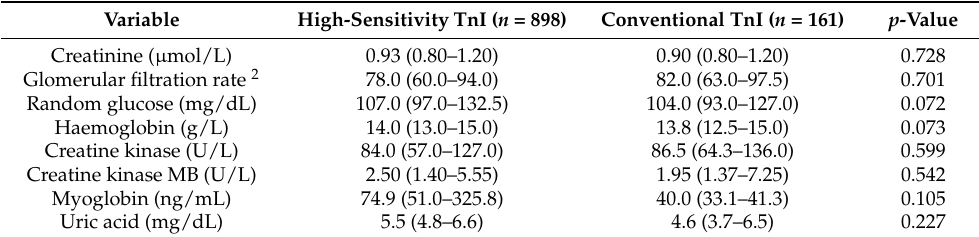
Table 2. Laboratory results of patients with hsTnI versus conventional TnI 1